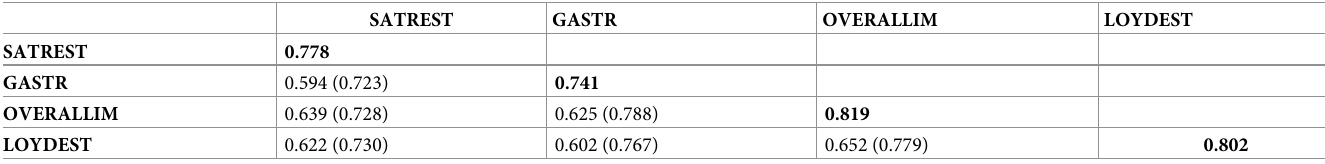
Table 5. Discriminant validity